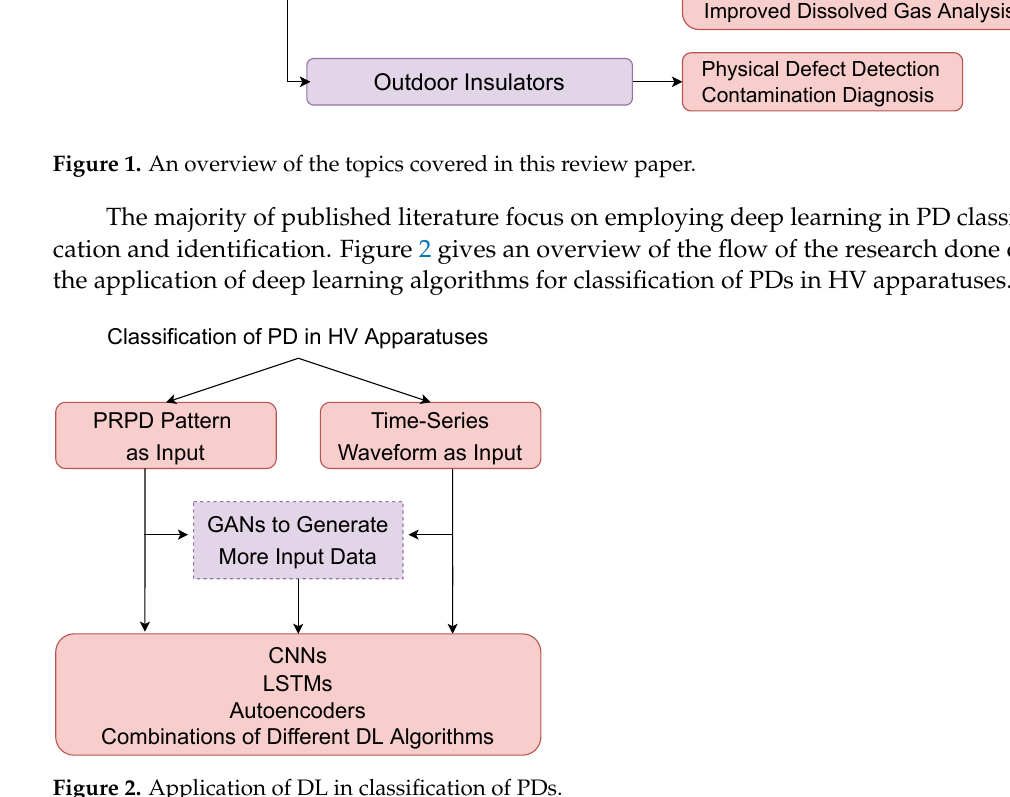
Figure 2. Application of DL in classification of